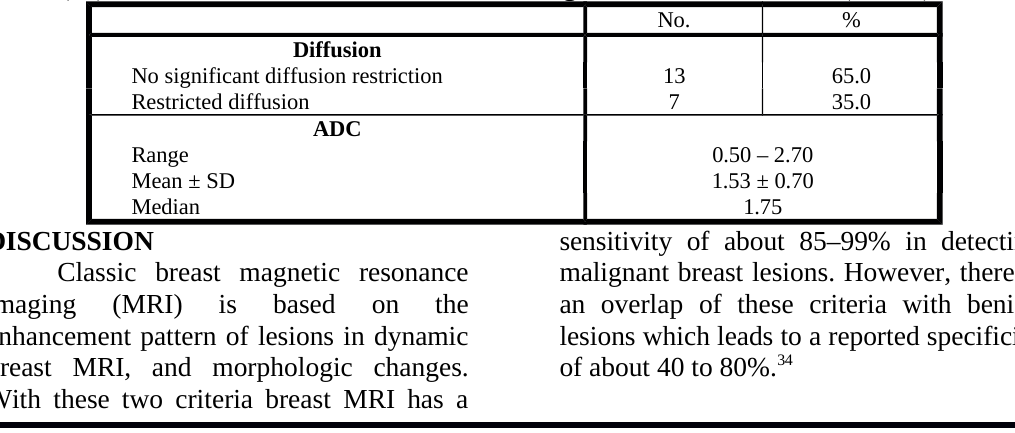
Table (13): Distribution of studied cases according to diffusion and ADC (n = 20)